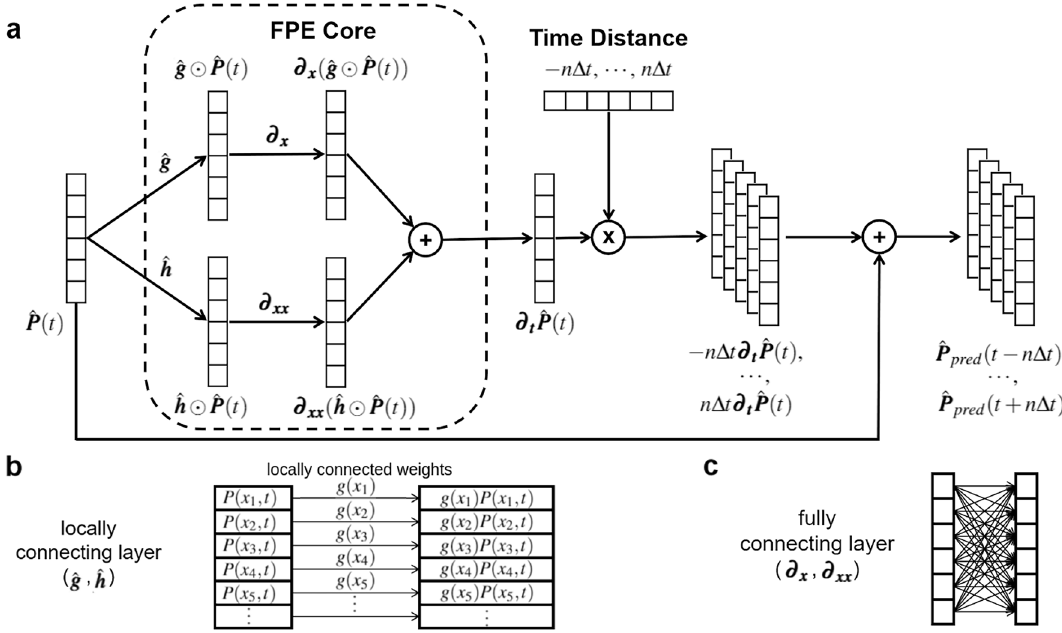
Figure 2. FPE-NN architecture. ( a ) The whole architecture of Fokker–Planck Equation Neural Network (FPE-NN). The time distance set used for training FPE-NN is a vector ( − n � t , . . . , n � t ) , but it changes